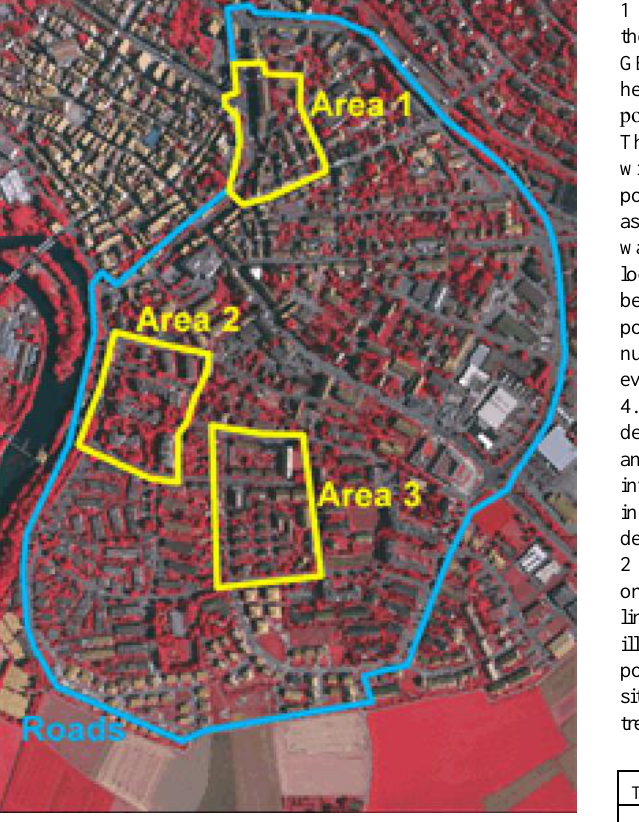
Figure 2. The area studies were highlighted on the aerial image.